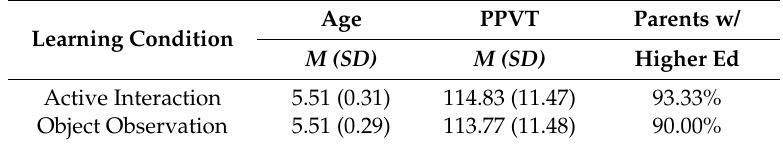
Table 3. After completing the study, children received a small toy as a gift for their participation. Table 3. Descriptive statistics for participants in Experiment